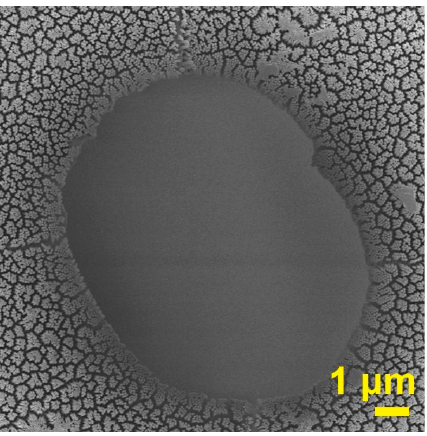
Figure 4. SEM image of the polymer replica with a cavitation.